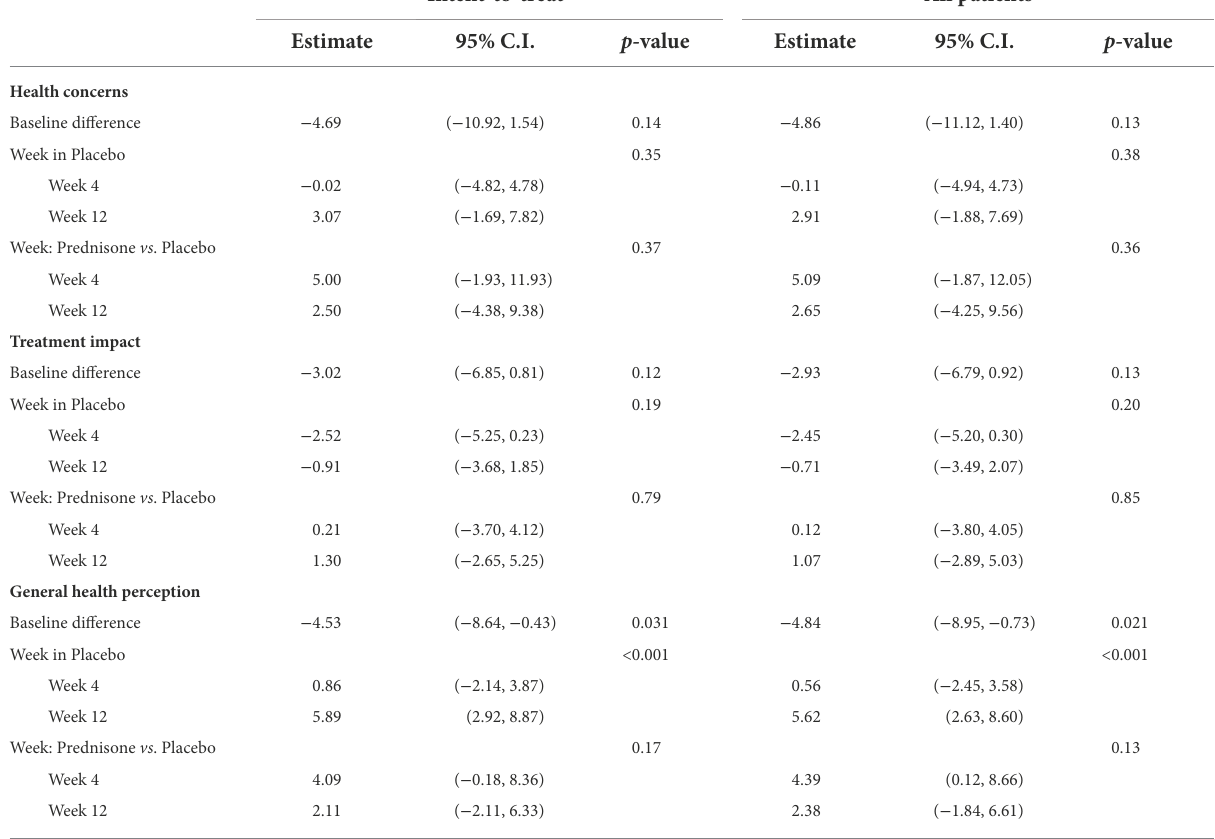
not directly translate into perceived improvements in psychosocial aspects of HRQoL. ‘Stigma’, ‘social relationships’ or ‘emotional distress’ can be considered distal constructs requiring structural